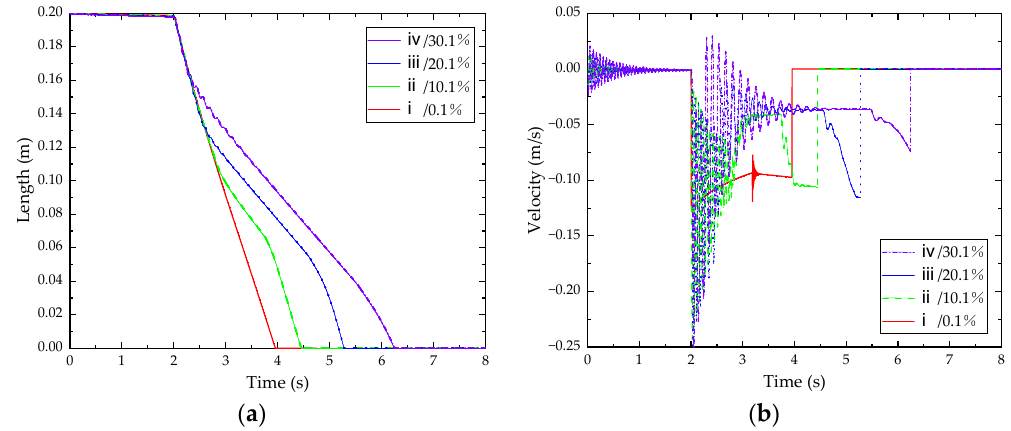
Figure 7. Influence of mixed air: ( a ) Piston displacement; ( b ) Piston Velocity. (3) Abnormal oil temperature.